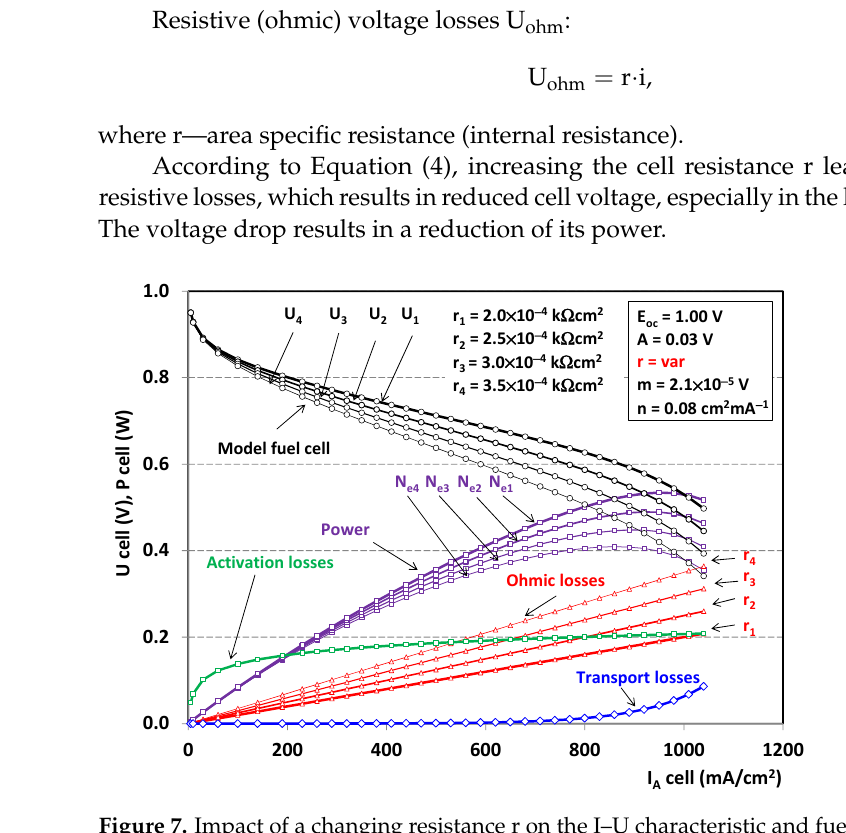
Figure 8. Impact of changes in mass m on the I–U characteristic and fuel cell power.